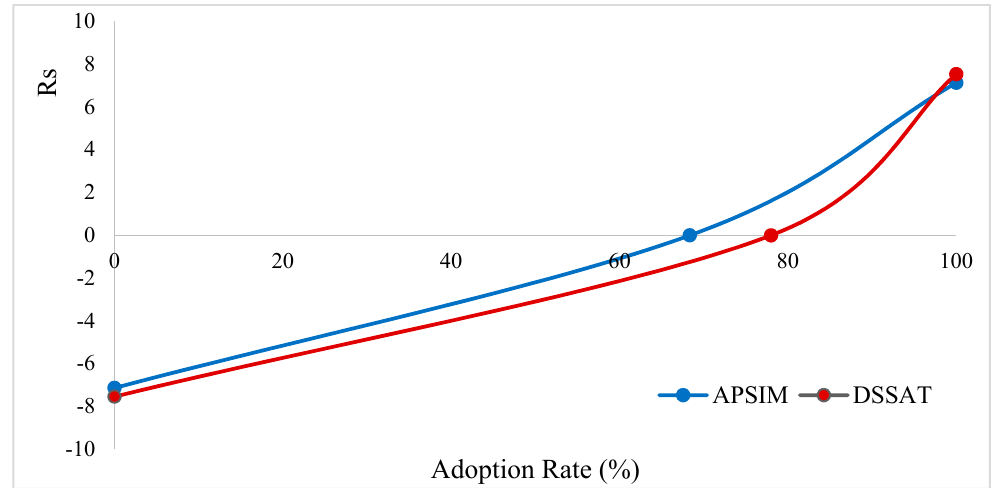
Figure 5. Adoption curve of climate change adaptation using crop Figure 4. Adoption curve of climate change adaptation using crop models .